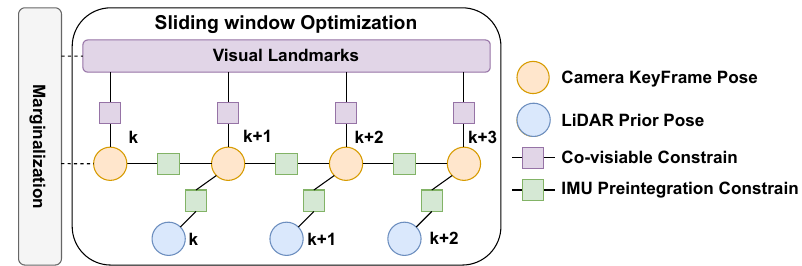
Figure 4. The factor graph of our visual inertial